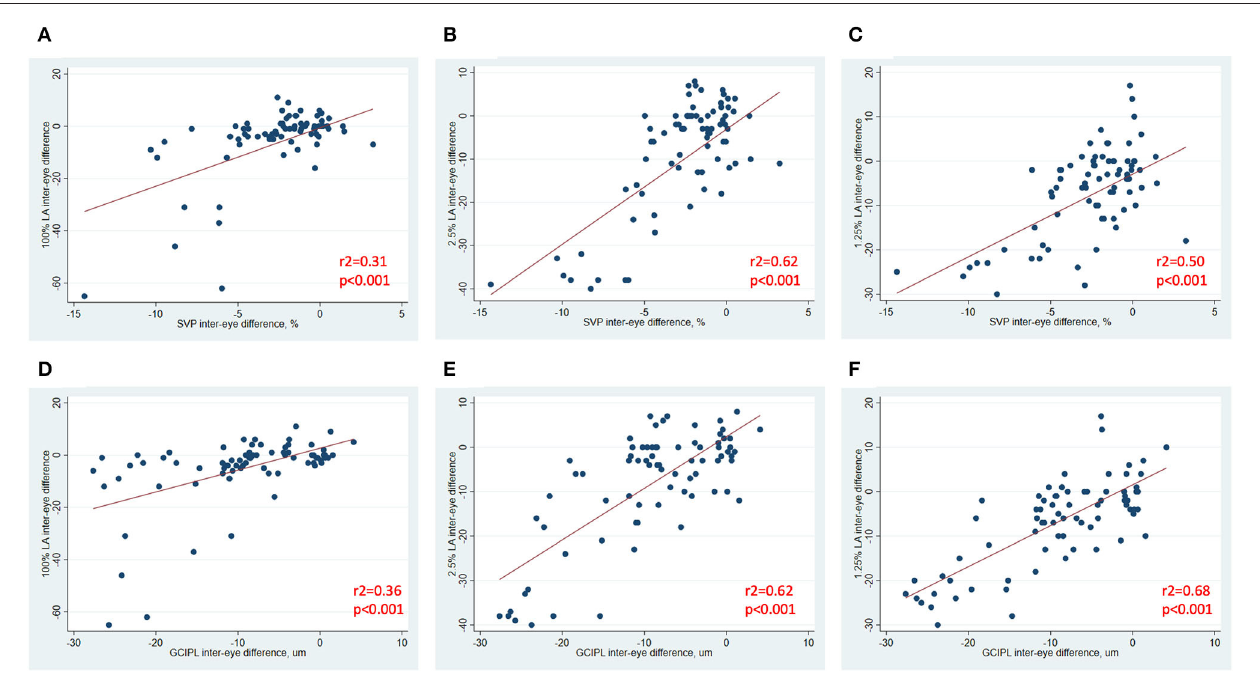
FIGURE 4 | Relationships between inter-eye differences in OCT/OCTA and visual function measures in MS ON patients. In MS ON patients at least 3 months post-ON (after resolution of the acute phase of ON), relationships between inter-eye differences in SVP density and 100% contrast LA, 2.5% contrast LA, and 1.25% contrast LA are demonstrated in (A–C) . In MS ON patients at least 3 months post-ON, relationships between inter-eye differences in GCIPL thickness and 100% contrast LA, 2.5% contrast LA, and 1.25% contrast LA are demonstrated in (D–F) . P -values were calculated using mixed-effects linear regression accounting for intra-subject correlations. R 2 -values were estimated from the mixed-effects model using the Snijders and Bosker